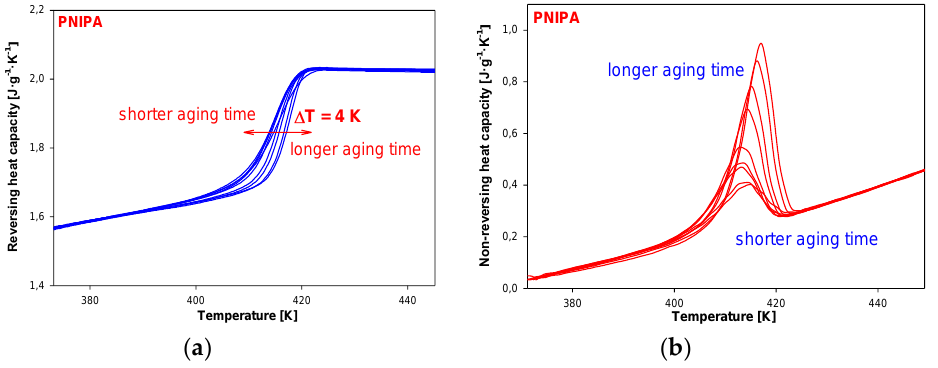
Figure 13. ( a ) Reversing heat capacity of amorphous PNIPA versus temperature obtained based on the isothermal aging. ( b ) Non-reversing heat capacity of amorphous PNIPA versus temperature obtained based on the isothermal aging. Table 2. Dependence of glass transition temperature on an aging time of the amorphous poly( N -isopropylacrylamide) obtained based on reversing heat capacity under the isothermal aging process measured by TMDSC (see Figure 13a).